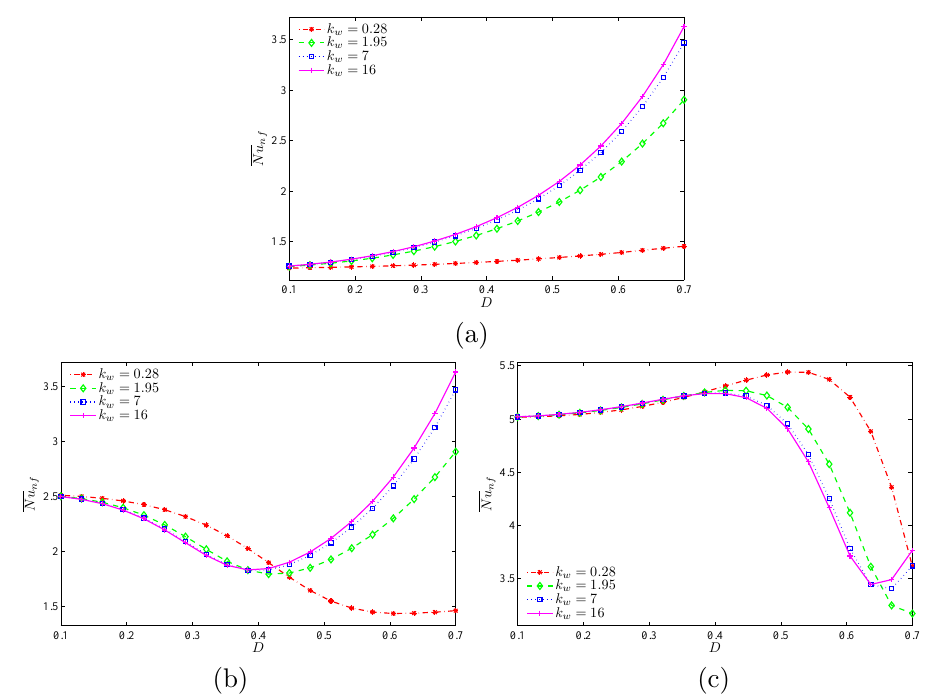
Figure 20. Variations of average Nusselt numbers with D for different k w for ( a ) Ra = 10 2 , ( b ) Ra = 10 4 and ( c ) Ra = 10 5 at φ =